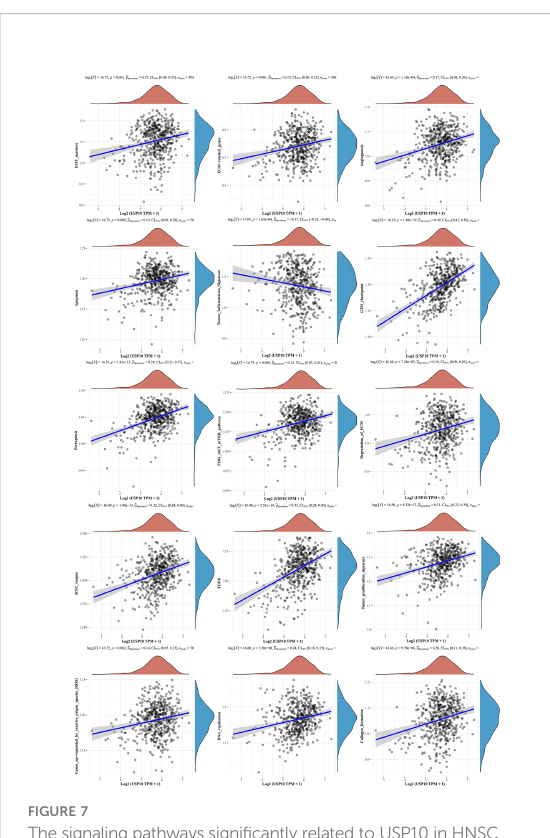
FIGURE 7 The signaling pathways signi fi cantly related to USP10 in HNSC included EMT, ECM, angiogenesis, apoptosis, tumor in fl ammation, G2/M checkpoint, ferroptosis, PI3K/AKT/mTOR, MYC, TGF- b , tumor proliferation, reaction oxygen species, DNA replication, and collagen formation. USP10, Ubiquitin-speci fi c peptidase 10; HNSC, head and neck squamous cell carcinoma; EMT, Epithelial- mesenchymal transition; ECM, extracellular matrix.